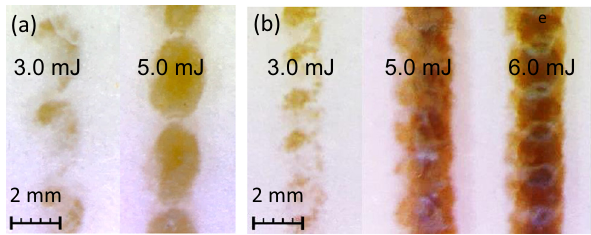
Figure 5: Ablation spots of ITO on glass with di ff erent laser energies ( a ) scanned at 1,000 mm/min and ( b ) scanned at 500